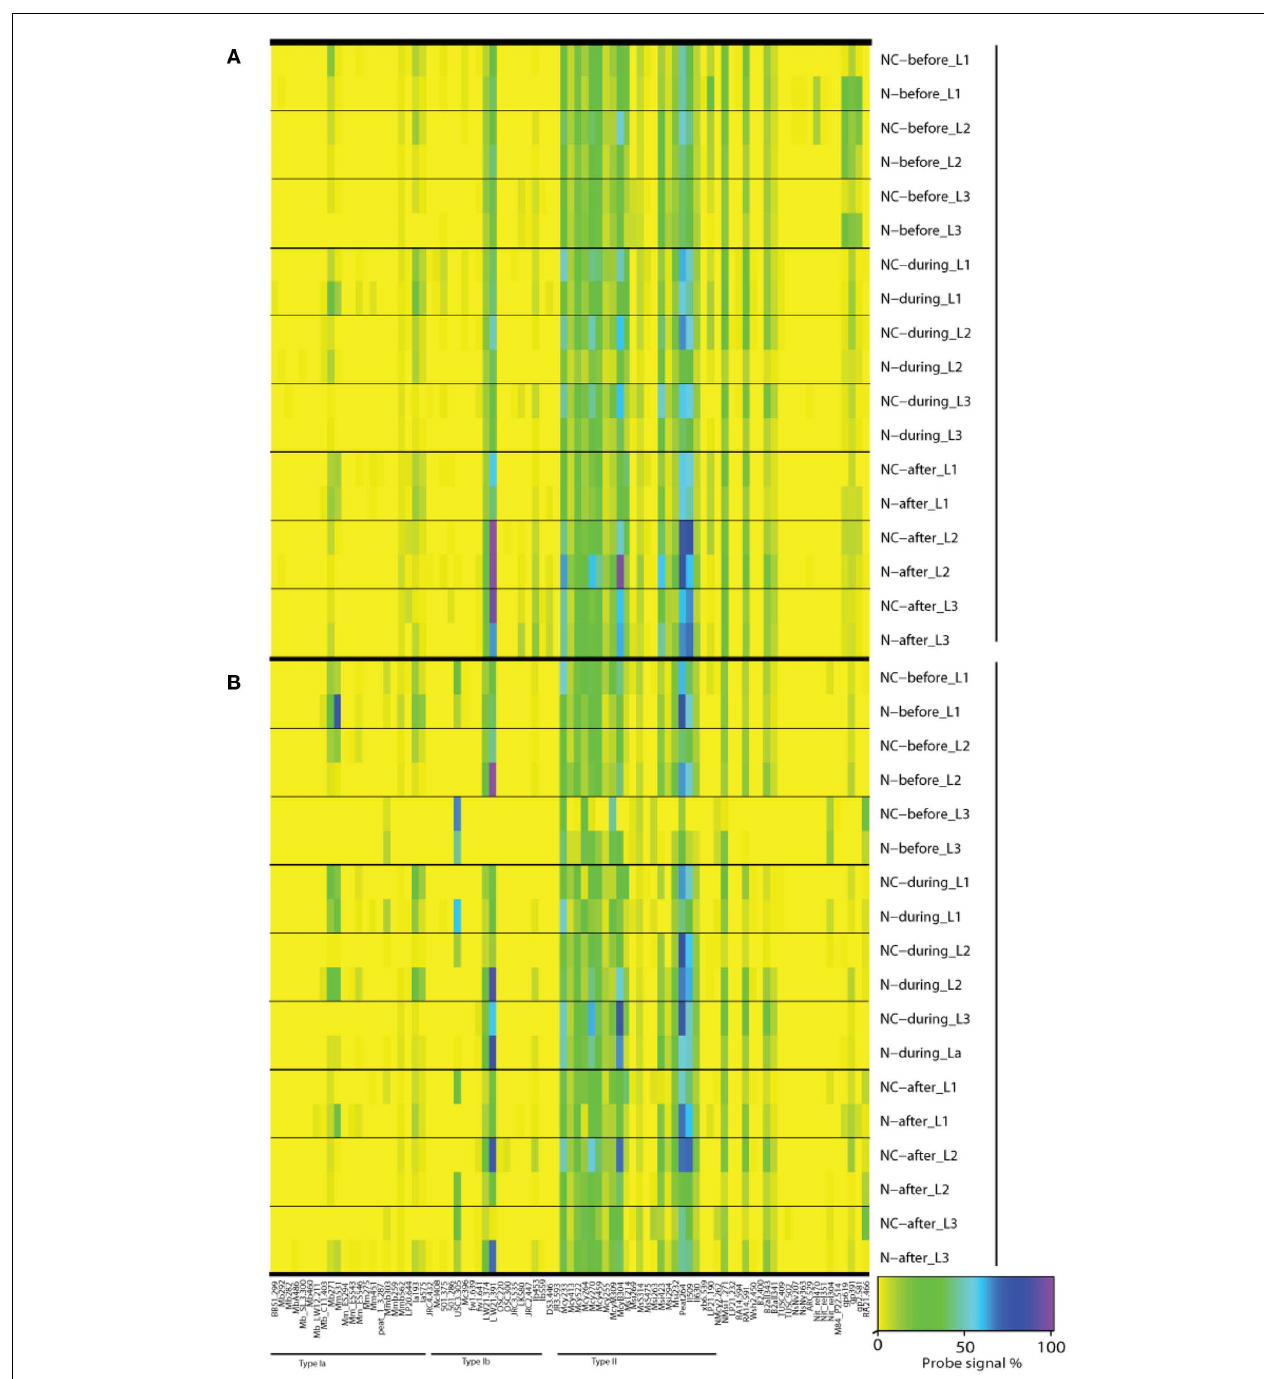
minimum signal intensity of a probe against reference hybridizations determined for each probe individually (Bodrossy et al., 2003). Only probes having positive hybridization are shown. N denotes nitrogen loading plots, NC control plots, L1 0–2cm layer, L2 2–10cm layer, and L3 10–20cm